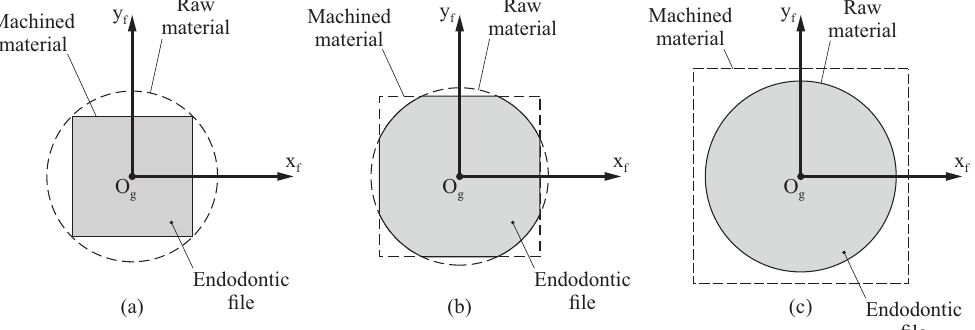
Figure 2. Cross-sections of the endodontic file at different positions along the z g axis: active part ( a ), transition area ( b ) and shaft ( c